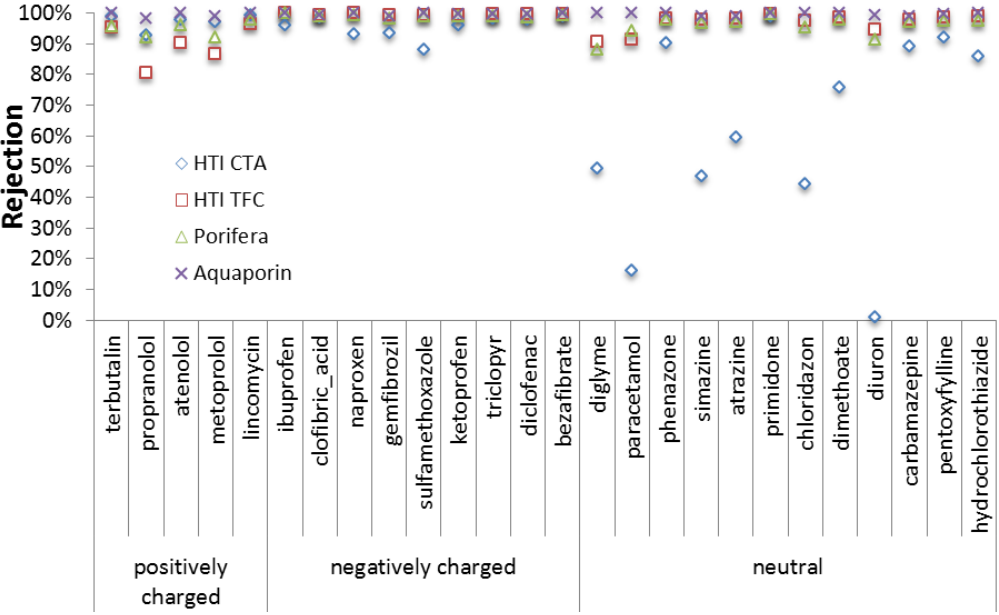
Figure 9. Rejection of TrOC in FO operation with four commercially available membranes (adapted from [126].